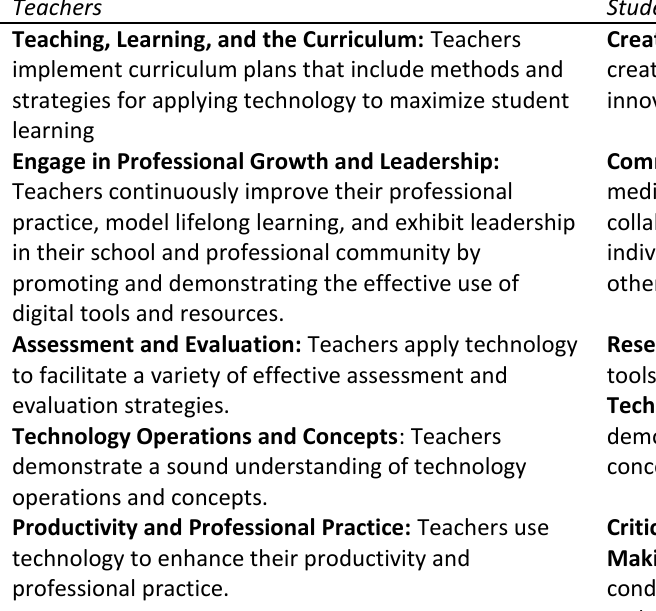
Table 3. Comparison of ISTE NETS-T and